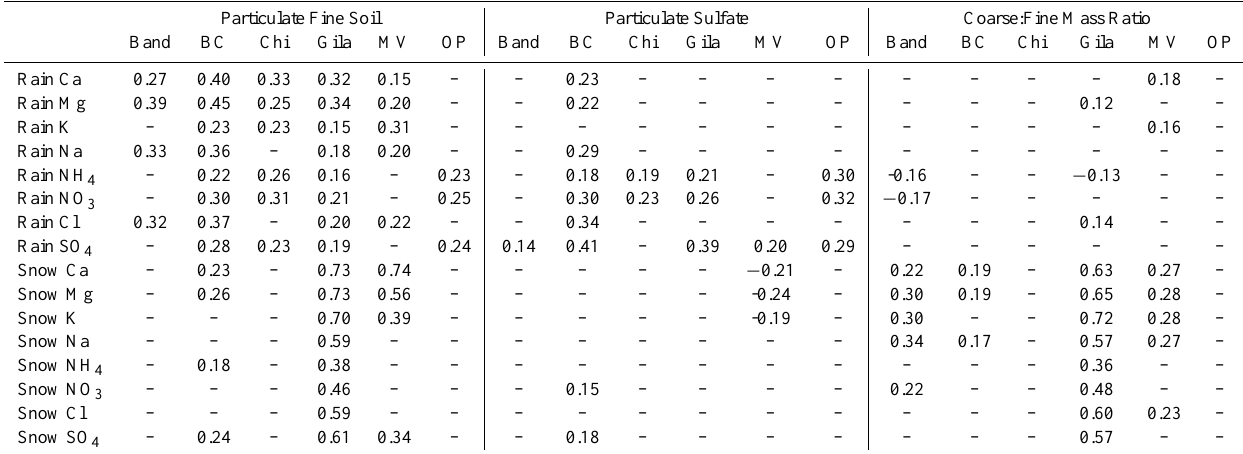
Table 3. Correlation ( r ) of aerosol mass concentrations (fine soil, sulfate) and the coarse:fine mass concentration ratio with precipitation species mass concentrations. Values are only shown when statistically significant (95%) with a two-tailed Student’s t test. There are no snow data at Organ Pipe. The sample range for data below is